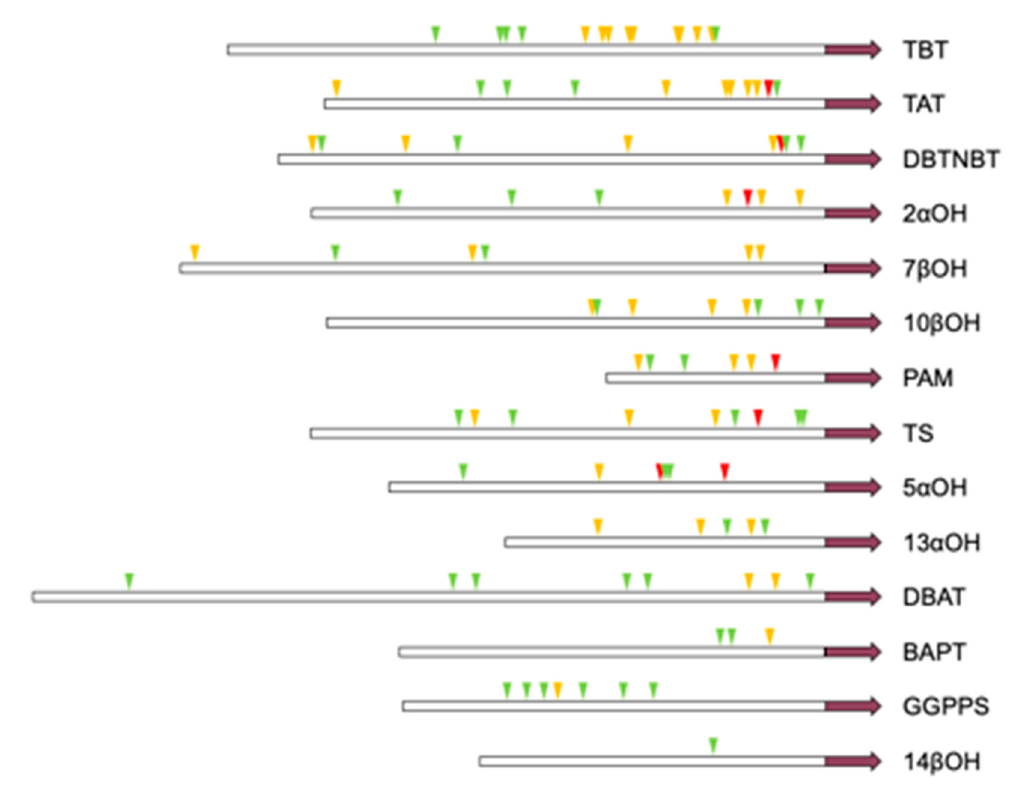
Figure 5. Location map of cis-elements in the paclitaxel biosynthetic pathway gene promoter sequence. The white rectangles show the promoter region of the corresponding gene in proportion, the dark red arrow indicates the start of the coding frame of the gene; the red triangle indicates the G-box, and the yellow triangle indicates the high affinity E-box or the variant G- Box. The green triangle indicates low affinity or no effect E-box.